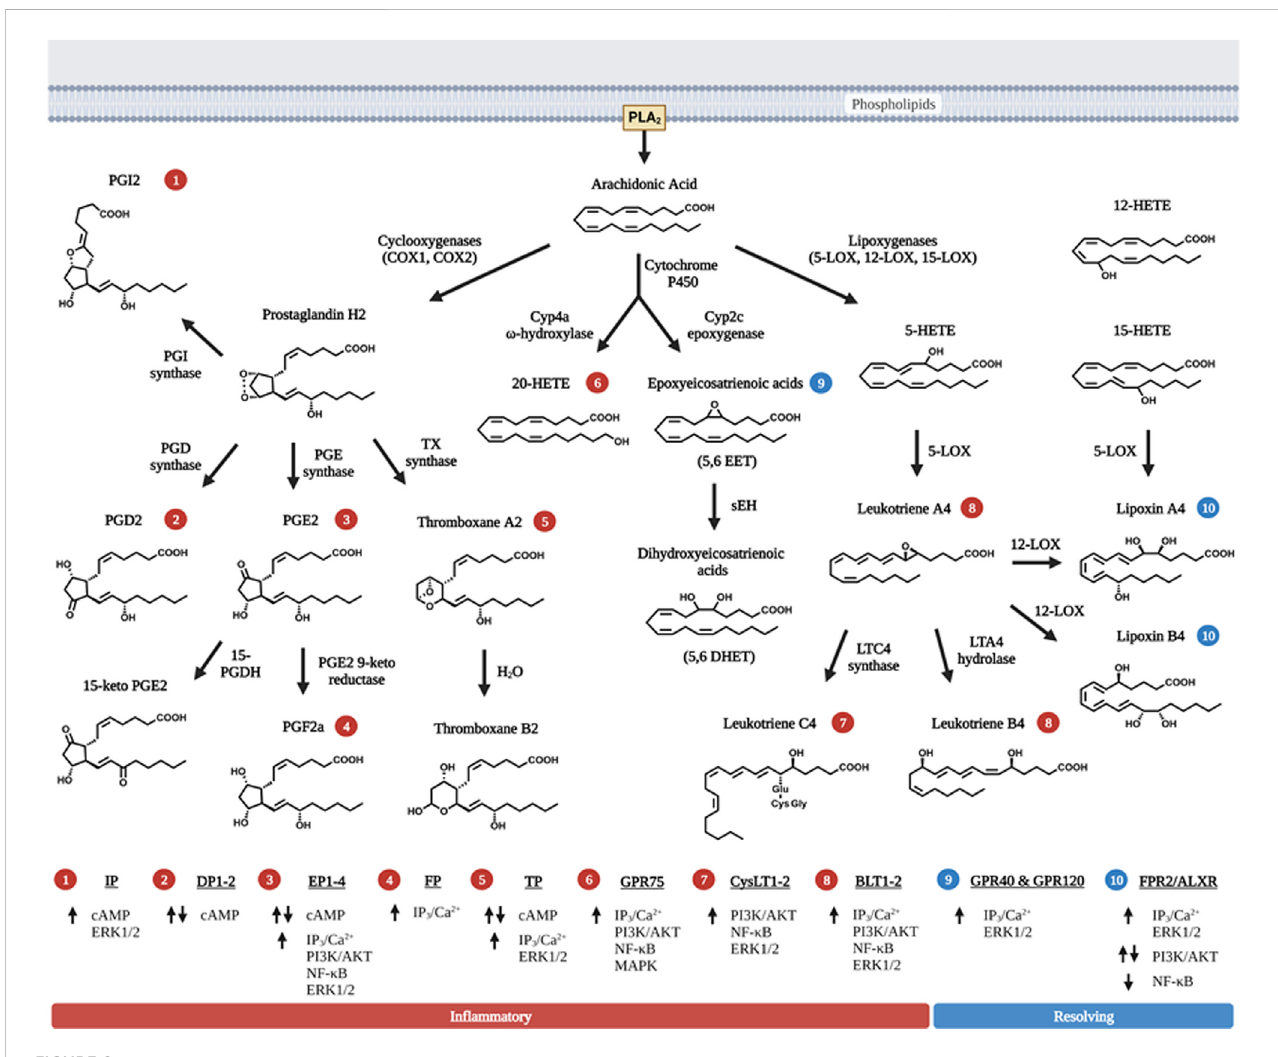
FIGURE 2 Metabolism of bioactive lipids with arachidonic acid as prototype polyunsaturated fatty acid precursor. Arachidonic acid (AA) is released via PLA 2 and metabolized into one of three distinct enzymatic pathways. First, two isoforms of cyclooxygenase (COX) metabolize AA by forming the signature 5-carbon ring structure observed in prostaglandins (PGH2, PGD2 and PGE2). The intermediate metabolite PGH2 is further metabolized to PGD2, PGE2, PGI2, or TXA2 via the action of speci fi c enzymes that leading to their synthesis. PGE2 and TXA2 (thromboxane A2) are further hydrolyzed to PGF2a and TXB2. Second, threeprimaryformsoflipoxygenase(LOX)acts onAAto produceleukotrienes(LTA4,LTB4and LTC4).12-LOXalso actupontheprimary leukotriene, LTA4 to produce lipoxins (LXA4 and LXB4), which have pro-resolving function towards in fl ammation, rather than pro-in fl ammation. 15-LOX action can also lead to the production of LXA4 and LXB4. Third, two groups of cytochrome P450 (Cyp2 and Cyp4) act upon AA to produce a series of HETE, EET and DHET products with 20-HETE being the most abundant and best characterized member of these metabolites. Like lipoxins, EETs also possess pro-resolving properties but they are relatively shorter half-life. Non-enzymatic reactions that produce eicosanoids-like compounds are not shown here in the fi gure. The numbers in circle — indicate receptors that the respective eicosanoids uses to signal. The receptors corresponding to the circled numbers are listed at the bottom of the fi gures with their respective signals. Up arrows are indicative ofactivation, and down arrows ofdownregulation ofexpression. Eicosanoids with red circled numbers have general functions towards in fl ammation whereas those with blue circled numbers are generally pro-resolving towards in fl ammation. Some eicosanoids play a dual role in both activation and inhibition of signaling cascades. Figure created with